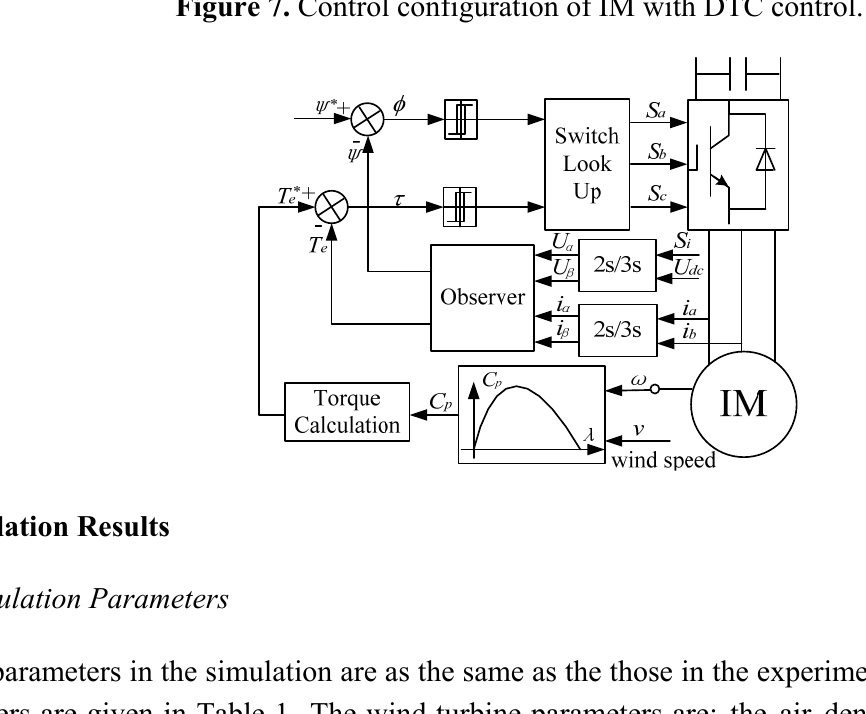
Figure 7. Control configuration of IM with DTC